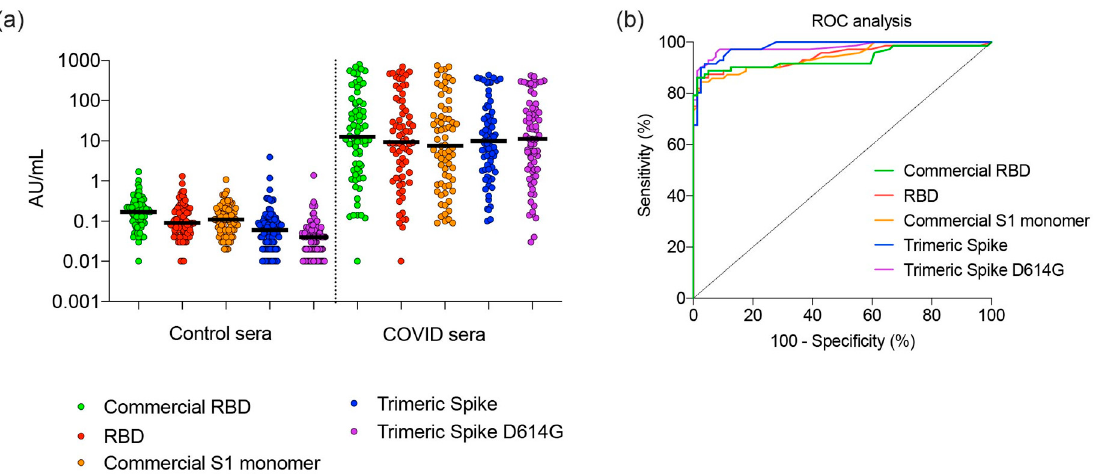
Figure 5. Performance of RBD, monomeric S1, and trimeric spike in a diagnostic assay to identify COVID-19 patients. ( a ) Control sera ( n = 151) and COVID-19 sera ( n = 72) collected at day 4–40 of symptoms were tested and compared for concentrations of immunoglobulin G. Median concentration and 95% confidence intervals are shown. ( b ) The sera tested in ( a ) were analyzed by ROC. Abbreviations: AU, arbitrary unit; RBD, receptor-binding domain; ROC, receiver operator characteristic; S1, Spike protein subunit 1.